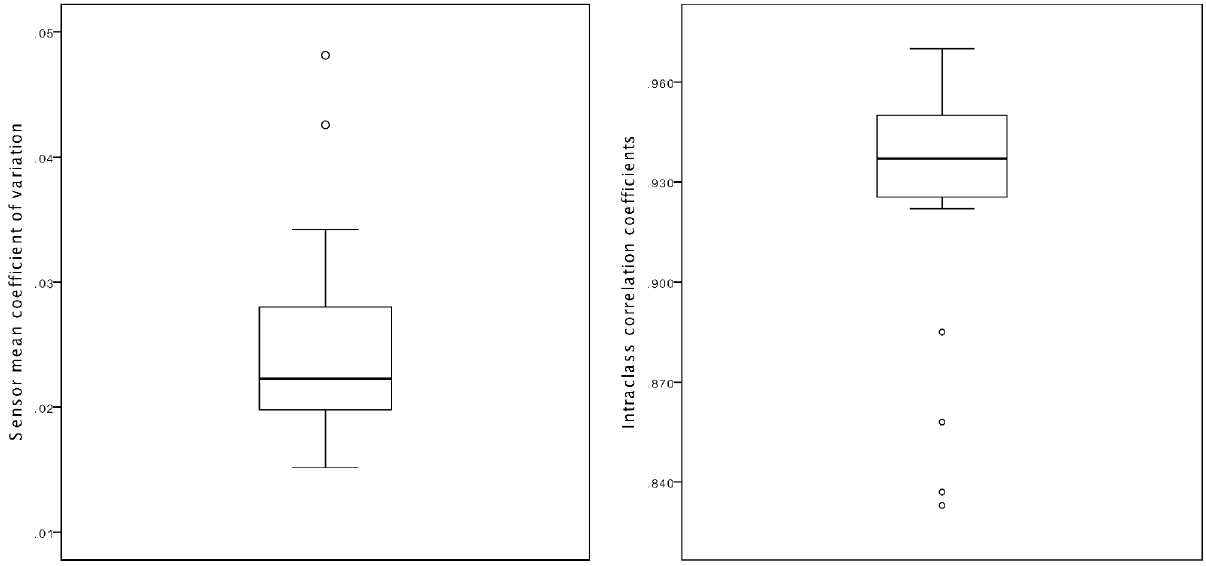
Fig. 4. Simple box-plot of the mean coefficient of variation (left) and simple box-plot of the intra-class correlation coefficients (right) of the 28 sensors used in the data